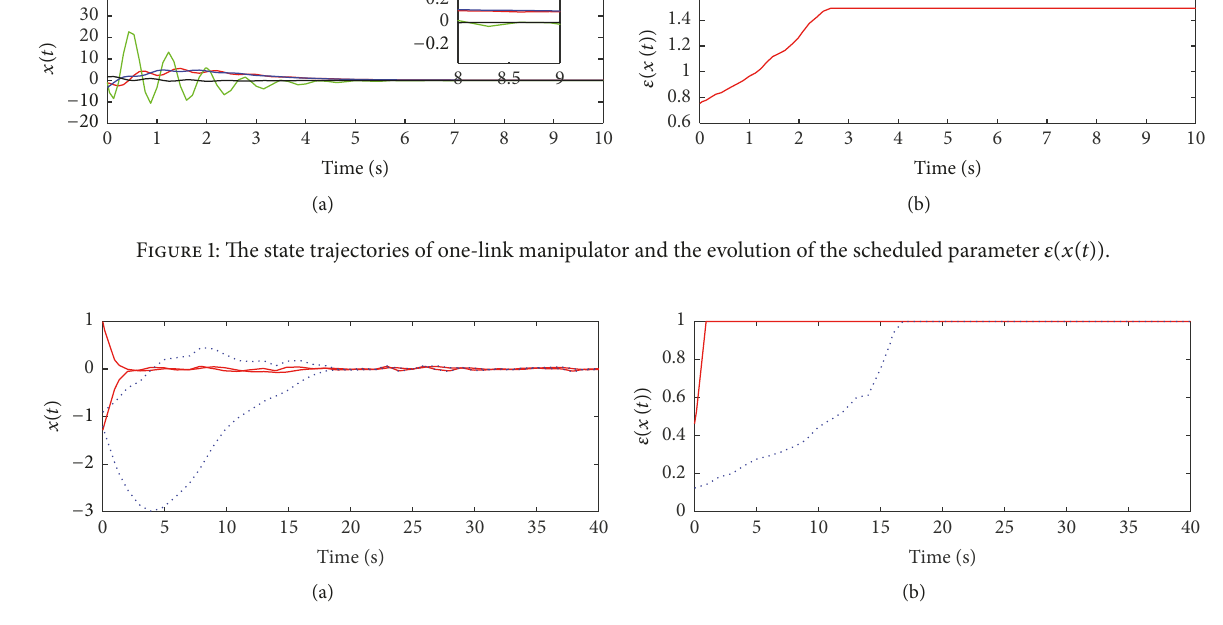
Figure 2: The state trajectories of double integrator and the evolution of the scheduled parameter 𝜀(𝑥(𝑡)) .